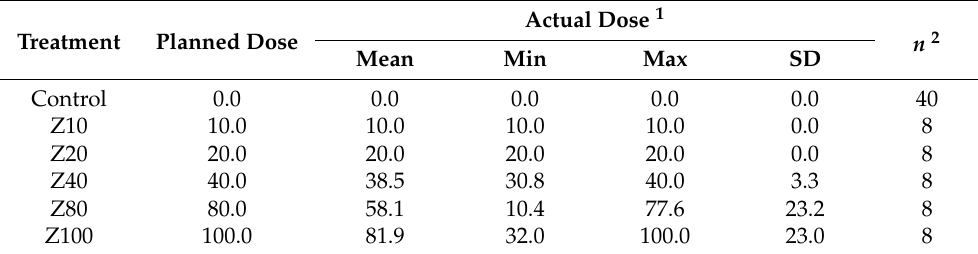
Table 2. Planned and actual doses (mg/kg) of tiletamine-zolazepam for the different treatments in pair-housed C57BL/6